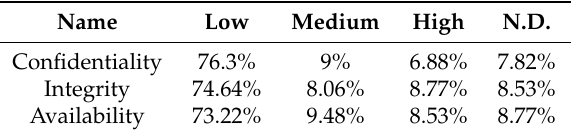
Table 5. Distribution of CIA requirements for configuration